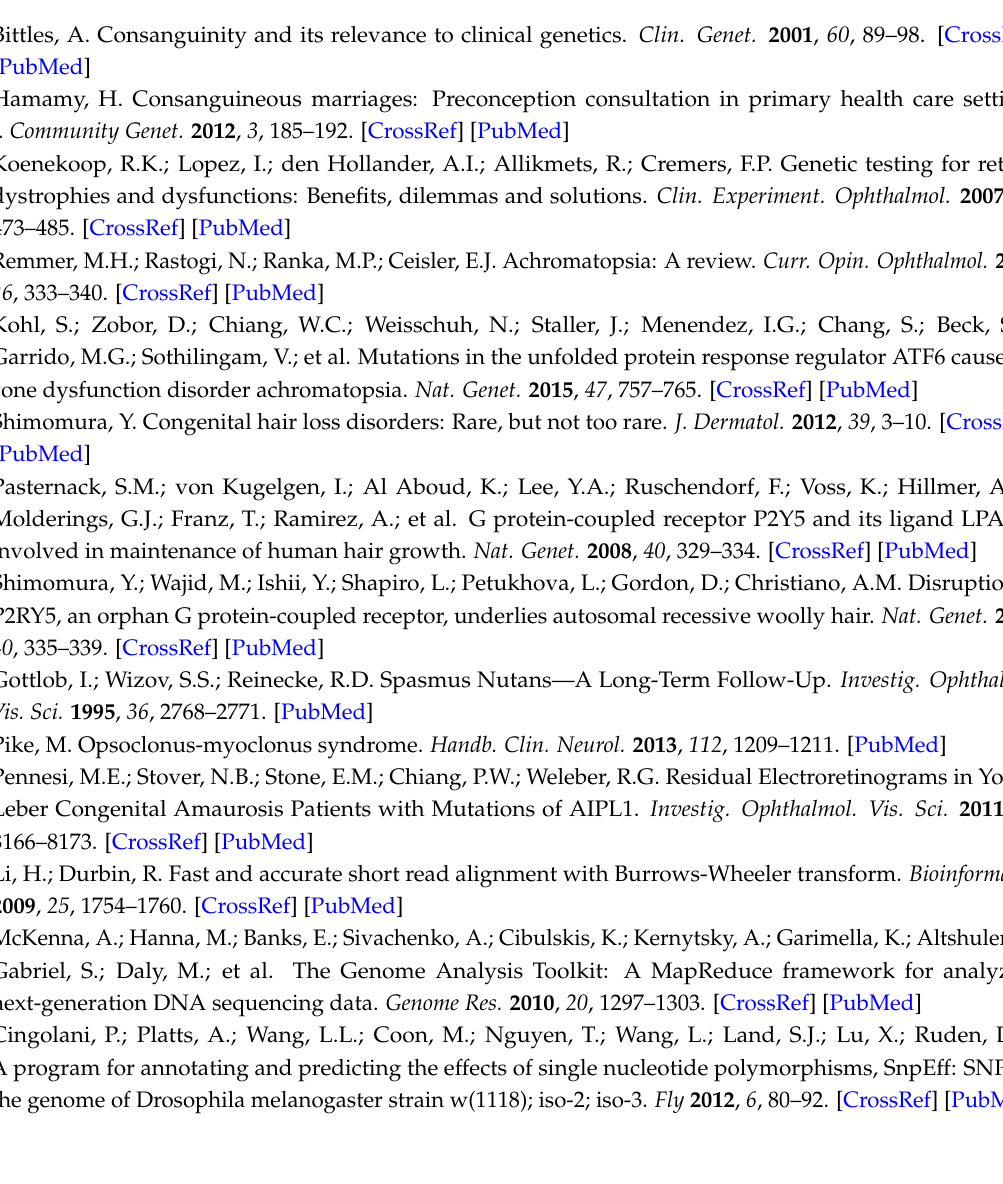
Figure S1: Patient 1 at the age of 13, alopecia is evident, Table S1: Analysis of the WES data of Patient II:1 and his parents, according to a recessive mode of inheritance (variants after filtering are listed), Table S2: Number of genetic variants obtained after WES data